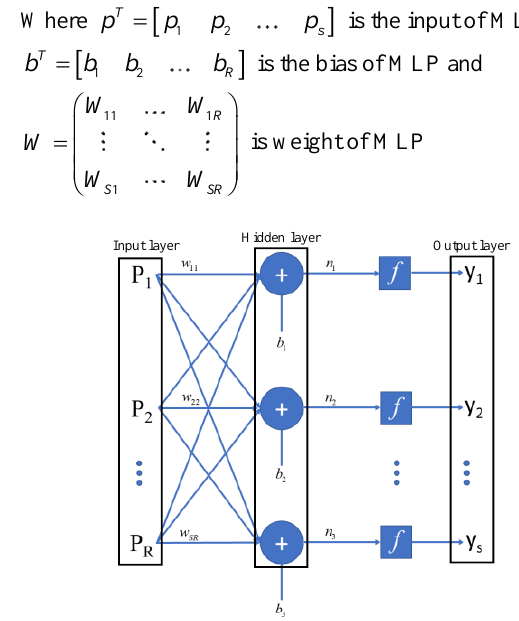
Fig.3 Multilayer Perceptron (MLP)